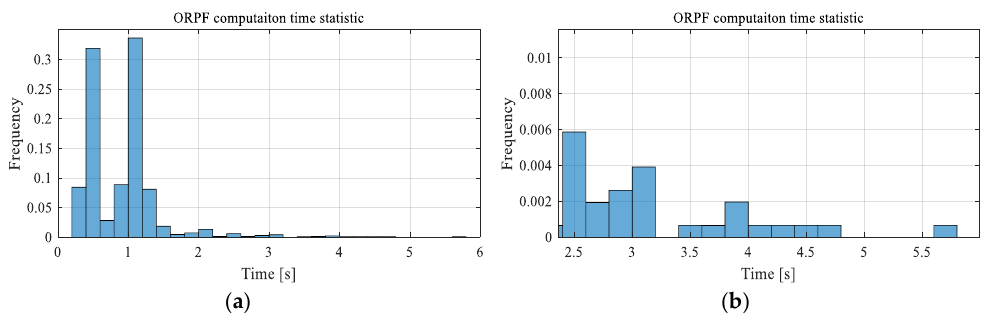
Figure 25. ORPF computation times statistics: ( a ) complete histogram; ( b ) detail of histogram.